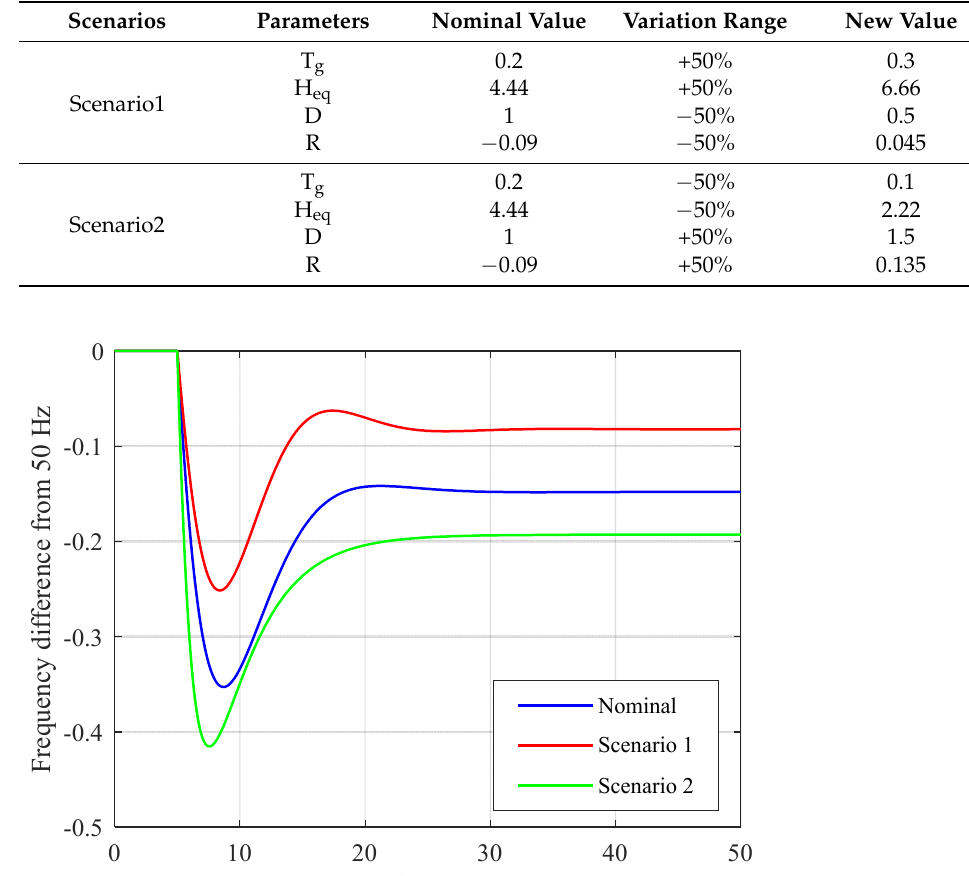
Table 14. The variation range of the parameters in the two scenarios.